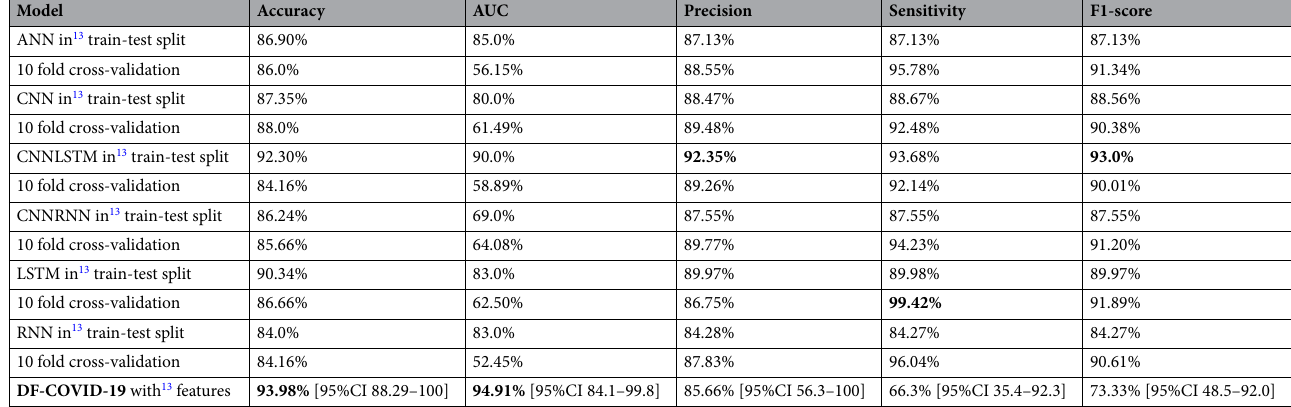
Table 2. The comparison results between DF-COVID-19 and other deep learning